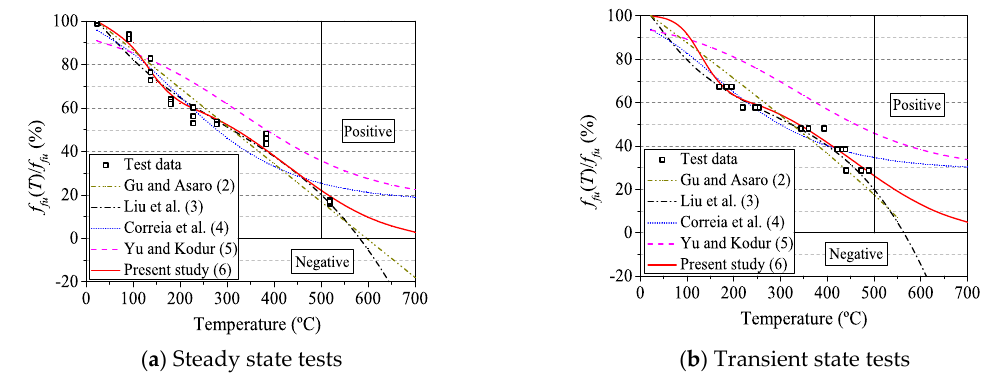
Figure 9. Nominal strength–temperature modeling curves.